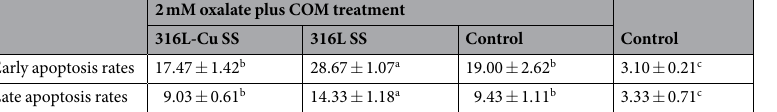
Table 1. Apoptosis rates of UECs incubated on samples and plates after different treatments. Data are presented as the mean ± SD. A significant difference at p < 0.05 is shown by different letters (a, b and c). Early apoptosis rates and late apoptosis rates were compared.